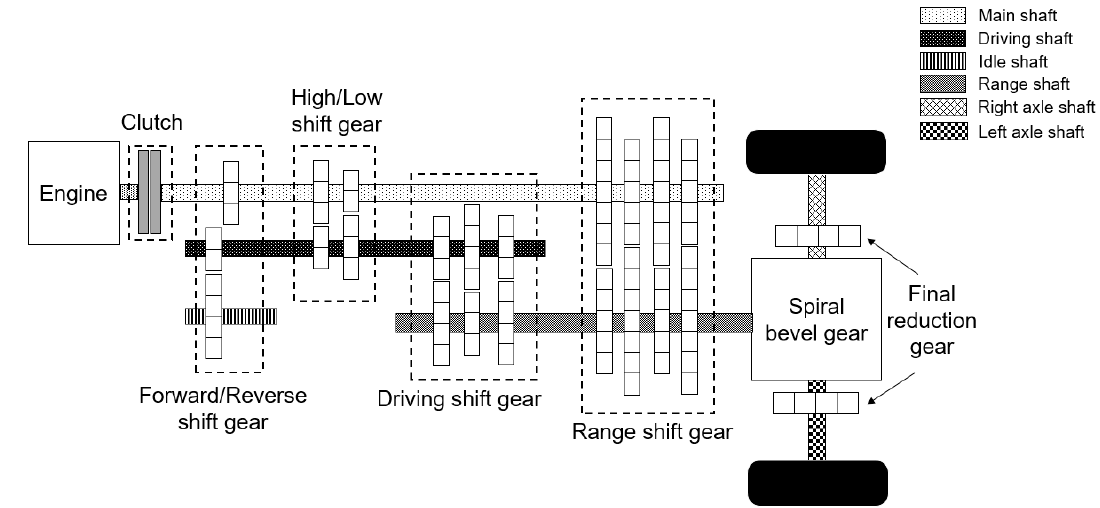
Figure 2. Power transmission system of wheeled tractor.